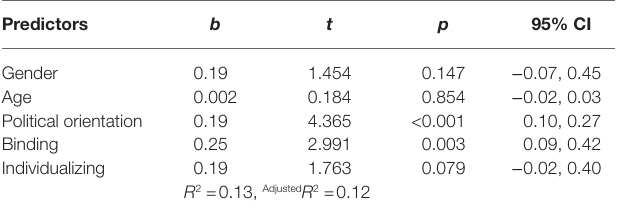
TABLE 2 | Predictive effects of the moral foundations and covariates on desired tightness, Study